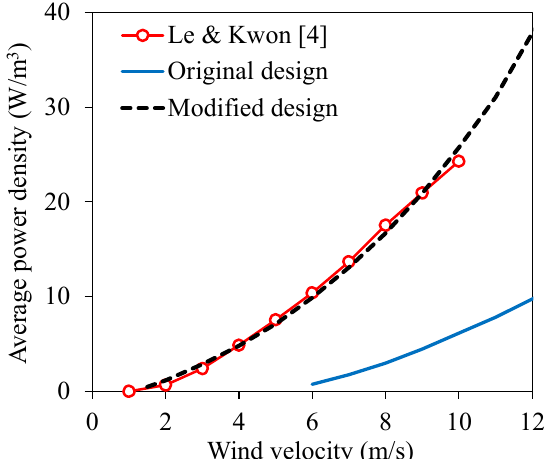
Figure 17. Maximum average power density under optimal load resistance obtained from numerical analysis.